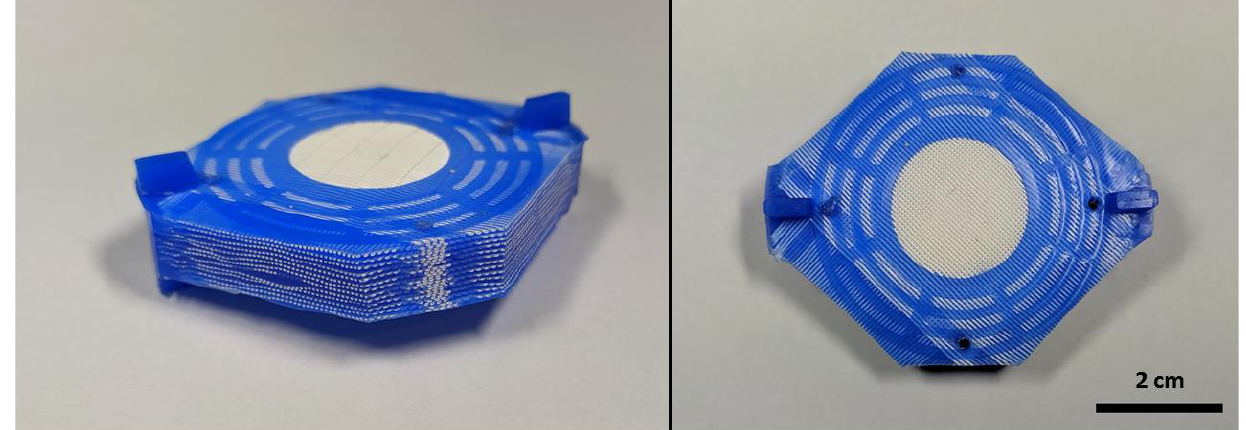
Figure 3. Photograph of a mid-size, silicone potted fiber module (29 layers), re-opened fibers, prior to assembly.